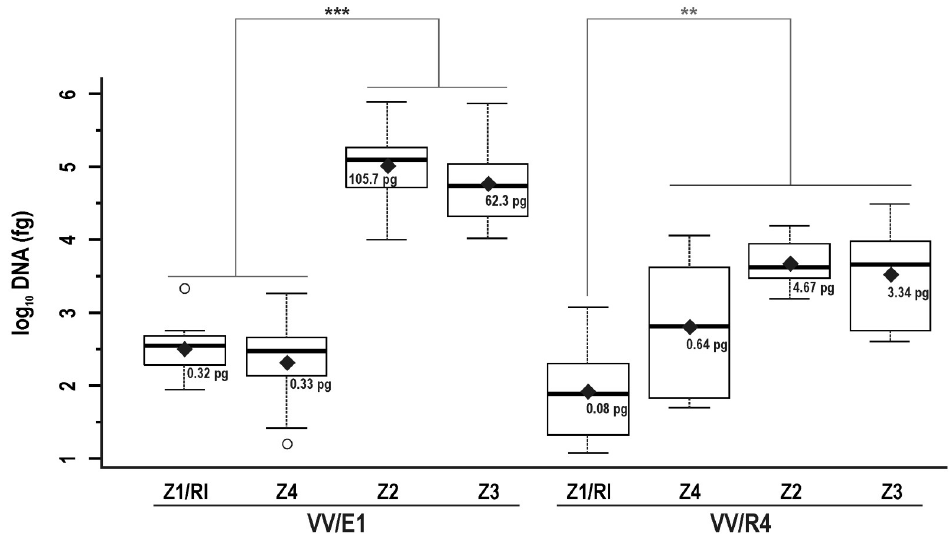
Fig 7. Quantification of Streptomyces sp. strain DNA at different zones of the rootstock inoculated by injection. Box plot corresponding to the DNA amounts of Streptomyces sp. VV/E1 and Streptomyces sp. VV/R4 strains detected in the different zones (Z1/R1 to Z4) analysed in the rootstock of plants inoculated by injection. Note that in this figure, DNA amounts are shown in pg. Black rhombuses correspond to average values (back transformed). Asterisks indicate significant differences according the LSD test: � p < 0.05; �� p < 0.01; ��� p < 0.001. Circles correspond to data outliers (outside the Q1-Q3 range).